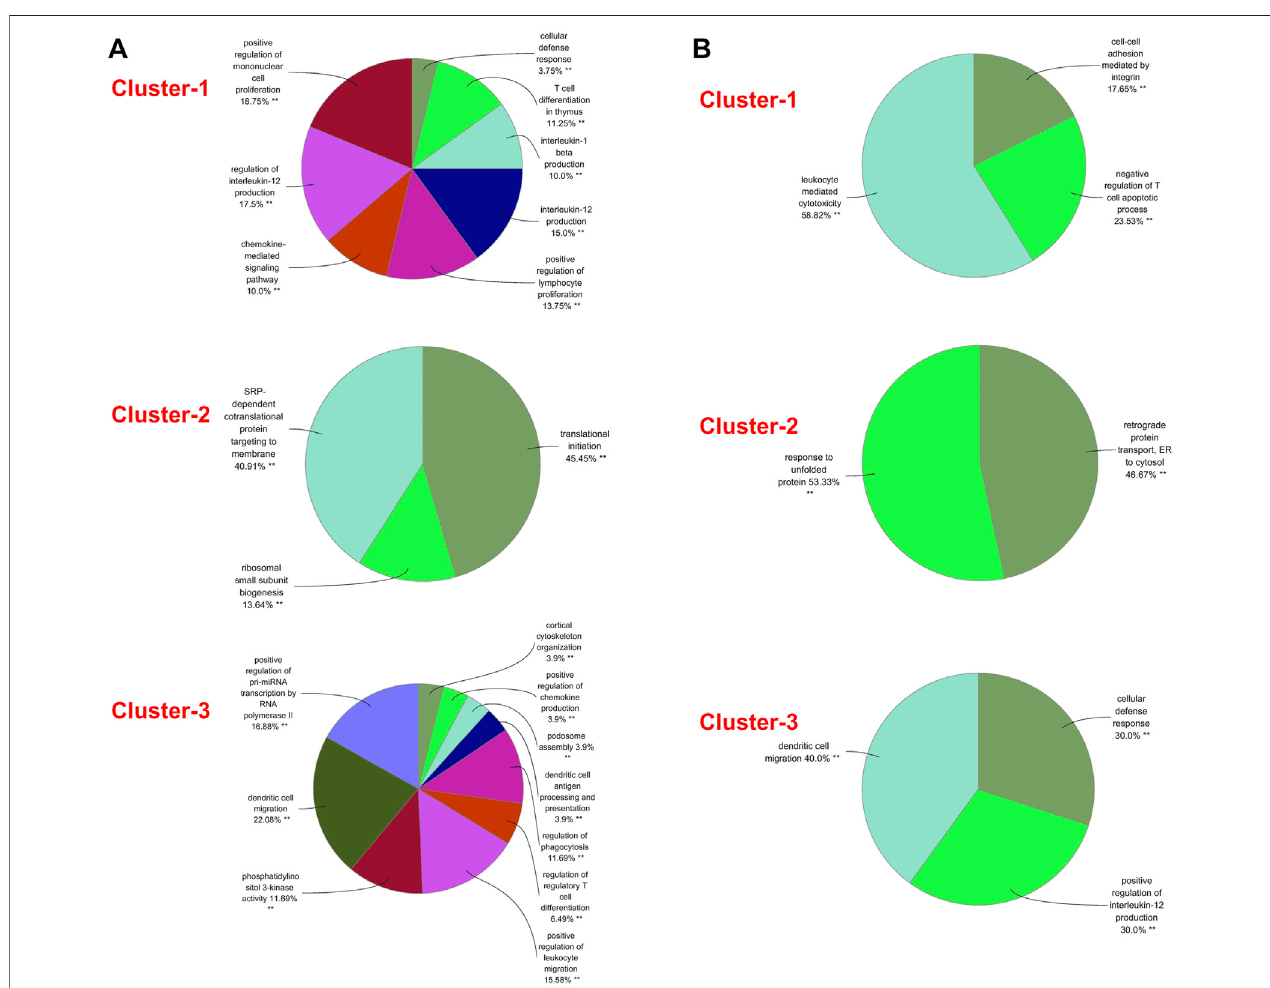
FIGURE 4 | GO biological process analyses of clusters. (A) The GO biological process analyses of three gene clusters in NAFLD. (B) The GO biological process analyses of three genes clusters in periodontitis. GO, gene ontology; NAFLD, nonalcoholic fatty liver disease. ** p < 0.05.